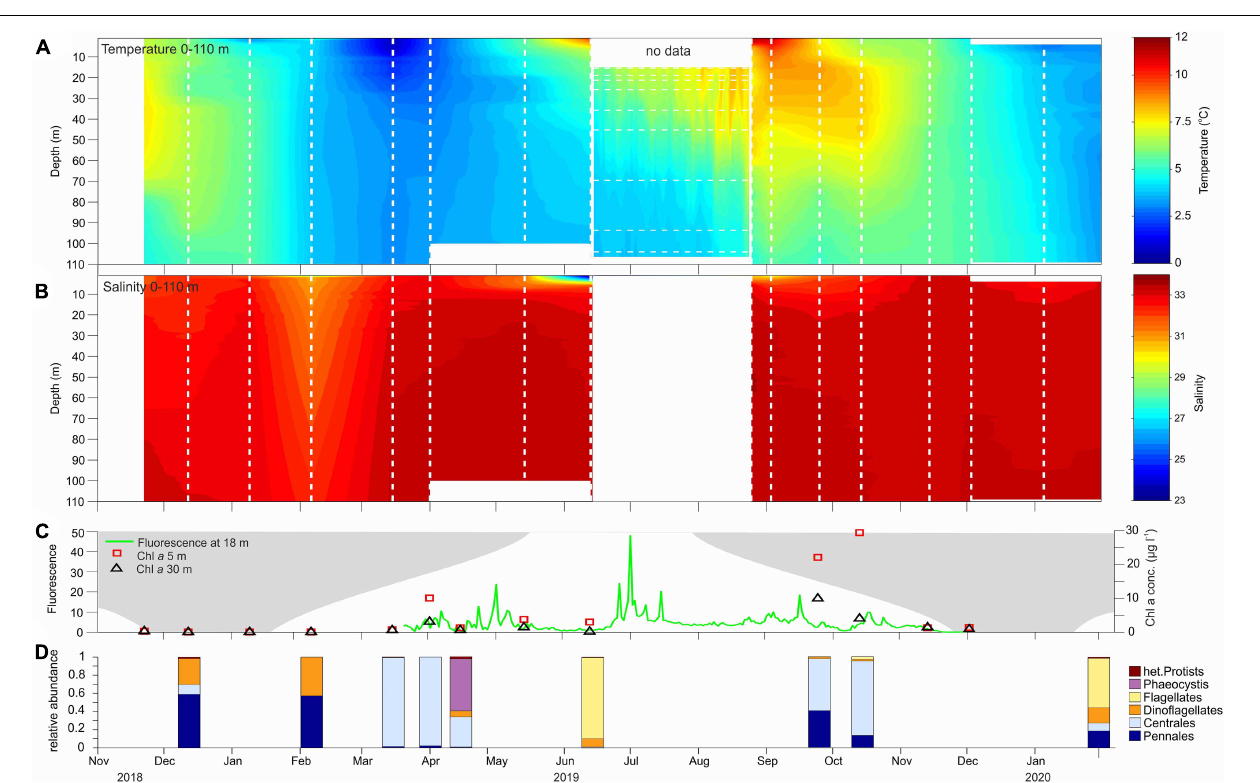
FIGURE 2 | Seasonal variation (November 2018–January 2020) in temperature (A) and salinity (B) based on CTD profiles taken at each sampling event (dates indicated by white vertical lines), fluorescence at 18 m and Chl a concentration at 5 and 30 m (C) , and taxonomic composition of phytoplankton community (D) . No CTD data available in (A,B) from 15 June to 18 August. Gap in (A) is filled with temperature measurements from mooring located close to the sampling site (with horizontal lines indicating depth of sensors along the mooring line). Fluorescence data available starting 15 March 2019; no fluorescence data after mid November 2019 due to biofouling of sensor. Seasonal changes in light climate is indicated in (C) with dark shaded areas corresponding to number of hours of darkness each